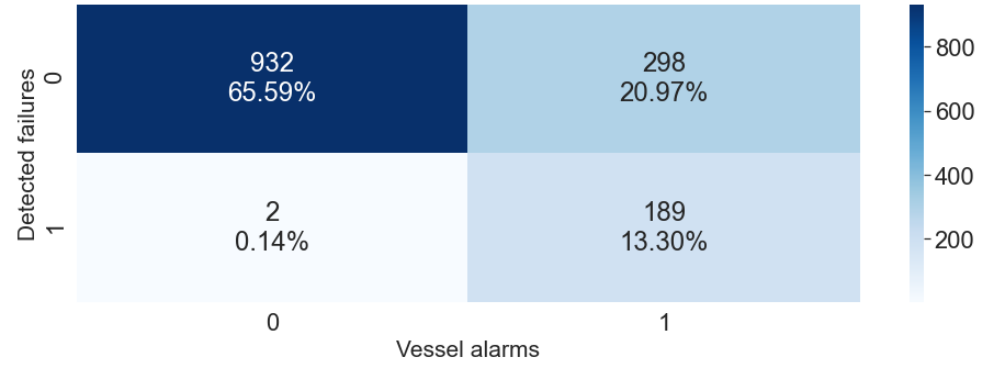
Figure 5. Confusion matrix of the failures detected by the BAM’s engine alarm system versus the anomalies detected by the